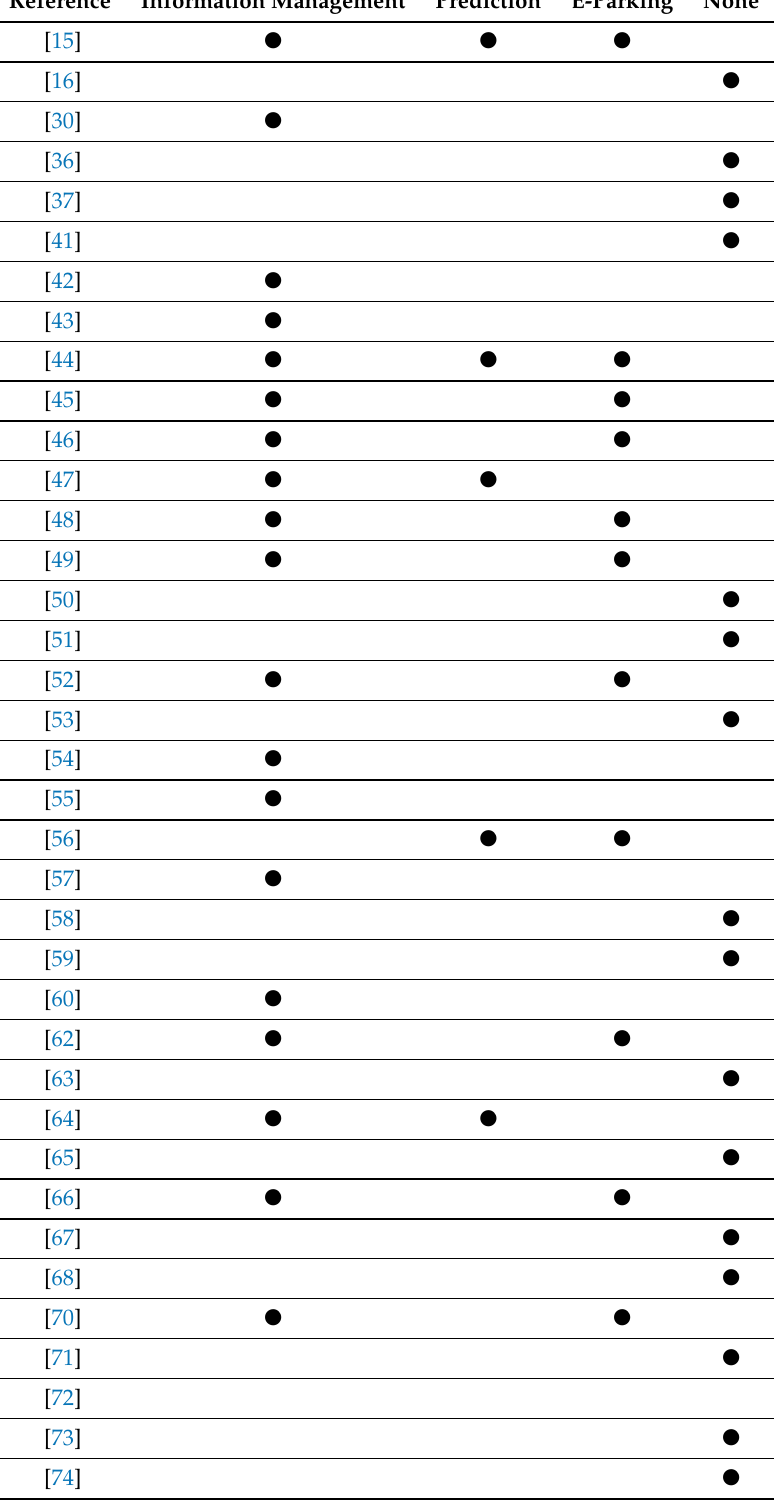
Table 4. Papers according to software solution